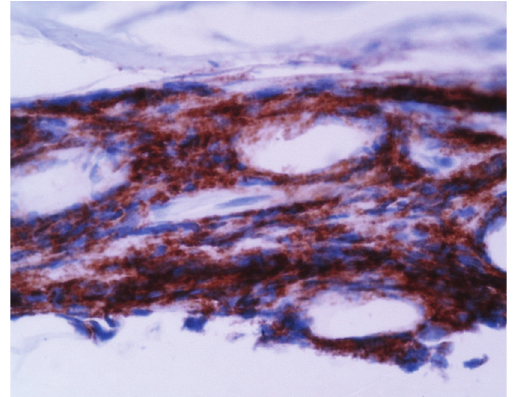
Figure 2: (Case 5). Immunoperoxidase staining with CD20, demonstrating the great majority of cells to be B lymphocytes, suggesting a humoral pathophysiologic diathesis.